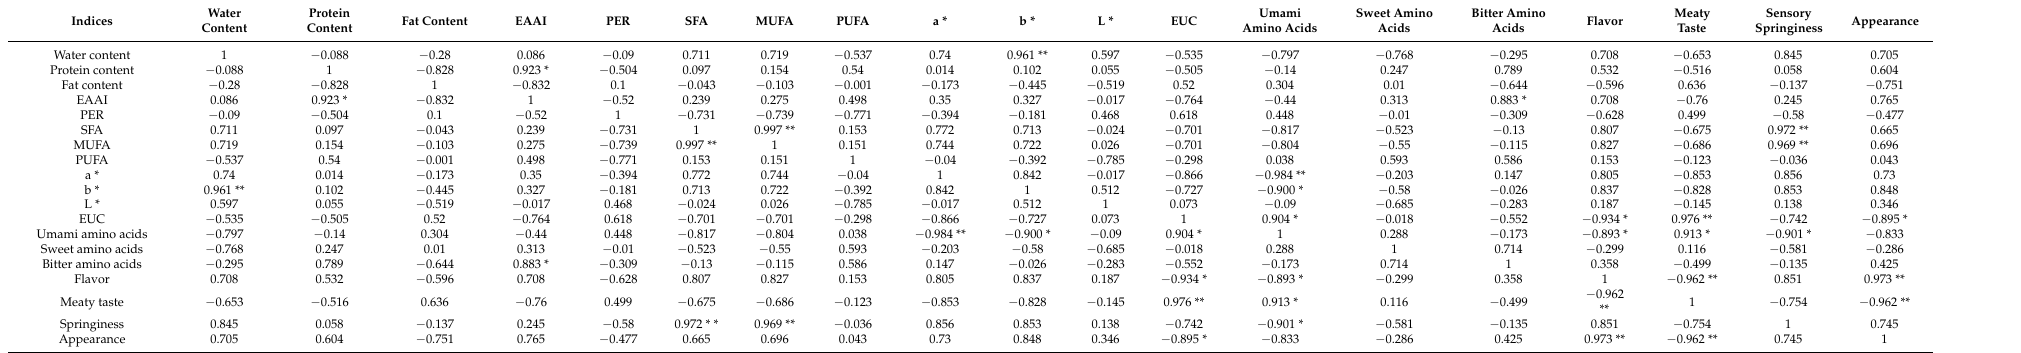
Table 10. Correlation analysis of the five types of